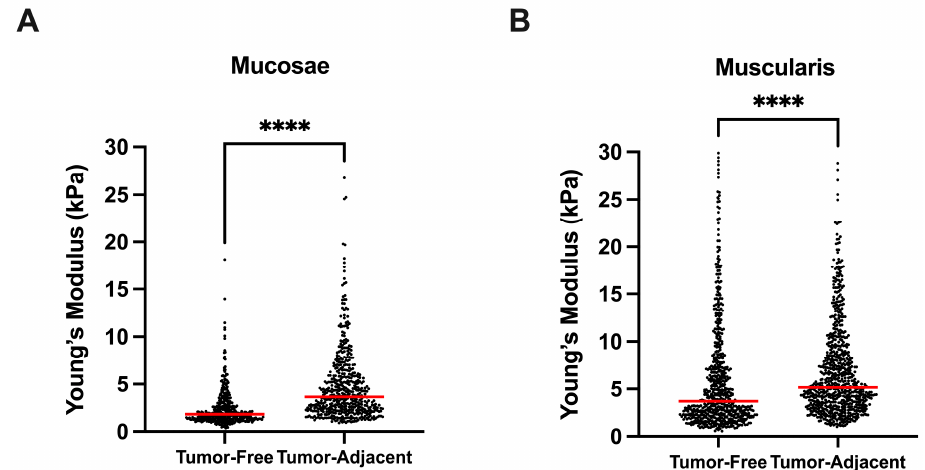
Figure 4. Comparison between bladder tumor-free vs. adjacent tissues, in mucosae ( A ) and muscu- laris propria ( B ) bladder wall layers. **** p < 0.0001.